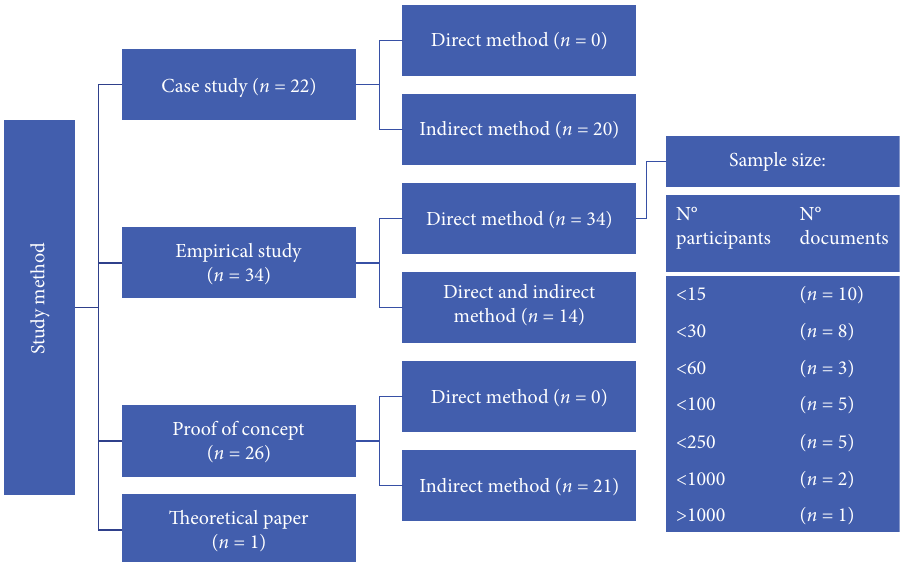
Figure 3: Documents grouped by study method, type of sample, and number of participants.